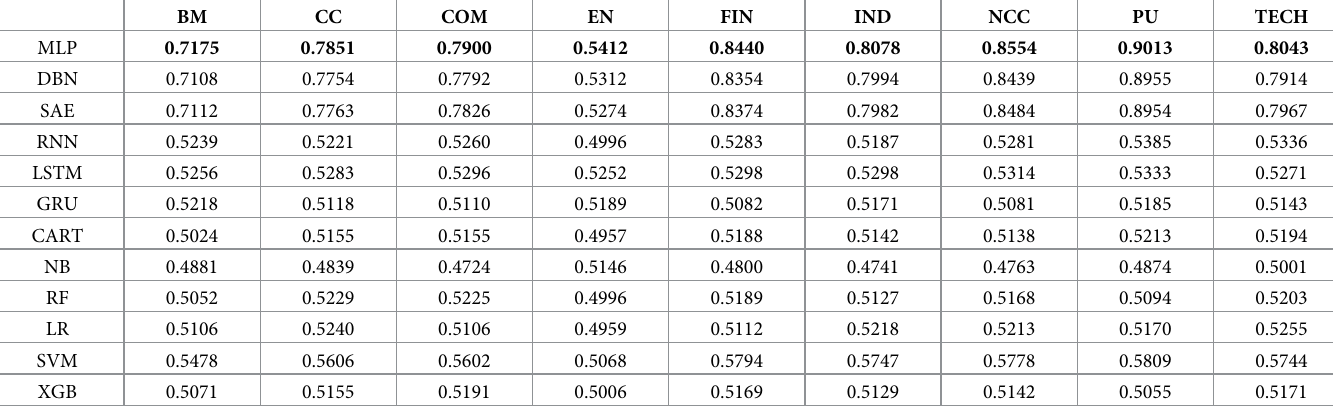
Table 4. Comparison of the WR of different trading algorithms in the different industries of SPICS. Best performance is in boldface. BM